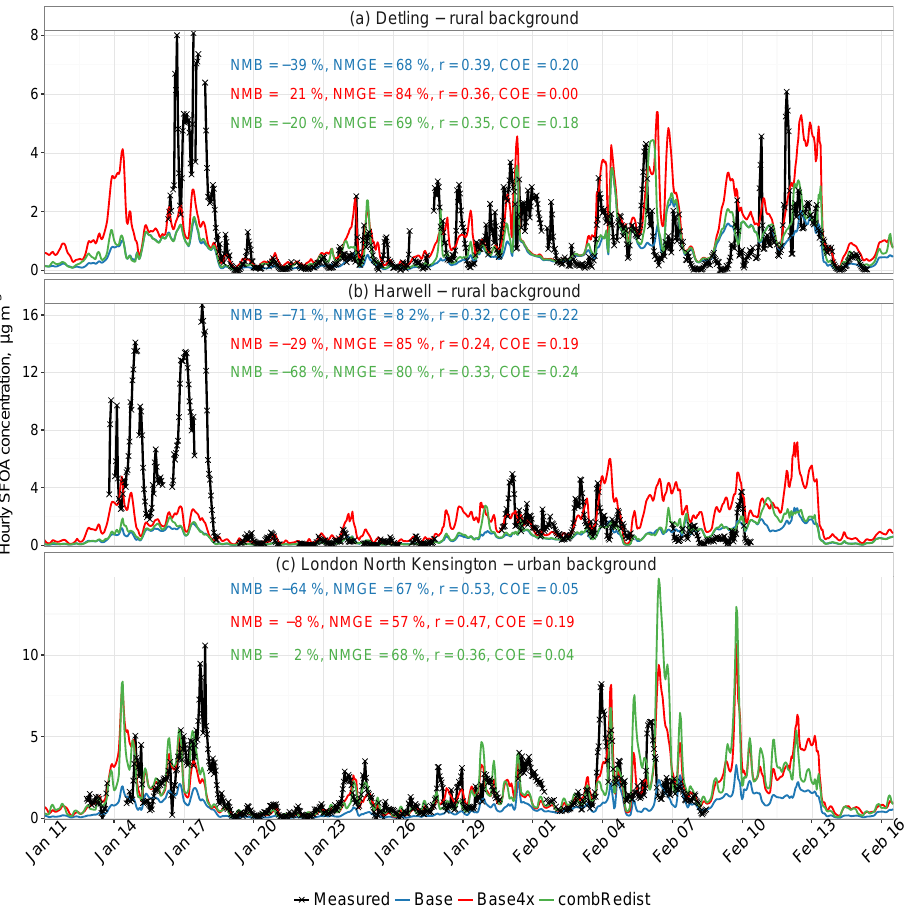
Figure 8. Time series of measured and modelled hourly average SFOA concentrations at the (a) Detling, (b) Harwell, and (c) London North Kensington measurement sites, winter IOP 2012. Note the different scales on the y